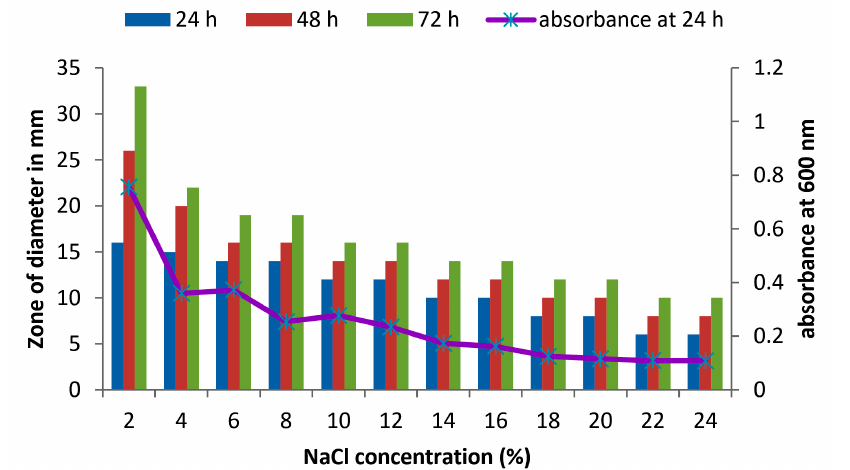
Fig. 6. Effect of NaCl on growth and DNase production of KVCMST-7A6. The zone of clearance in DNase test agar at various time of incubation indicated by bars: 24 hours, 48 hours, 72 hours and its growth indicated by its absorbance at 24